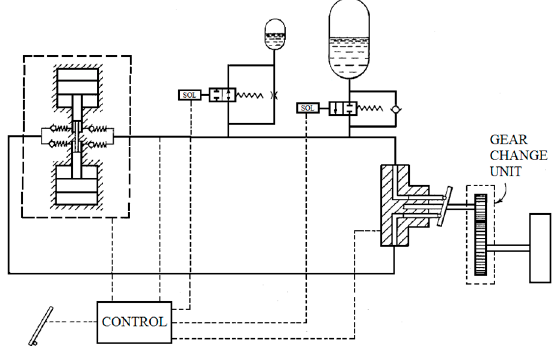
Figure 3. A propulsion system using an HFPE [8].